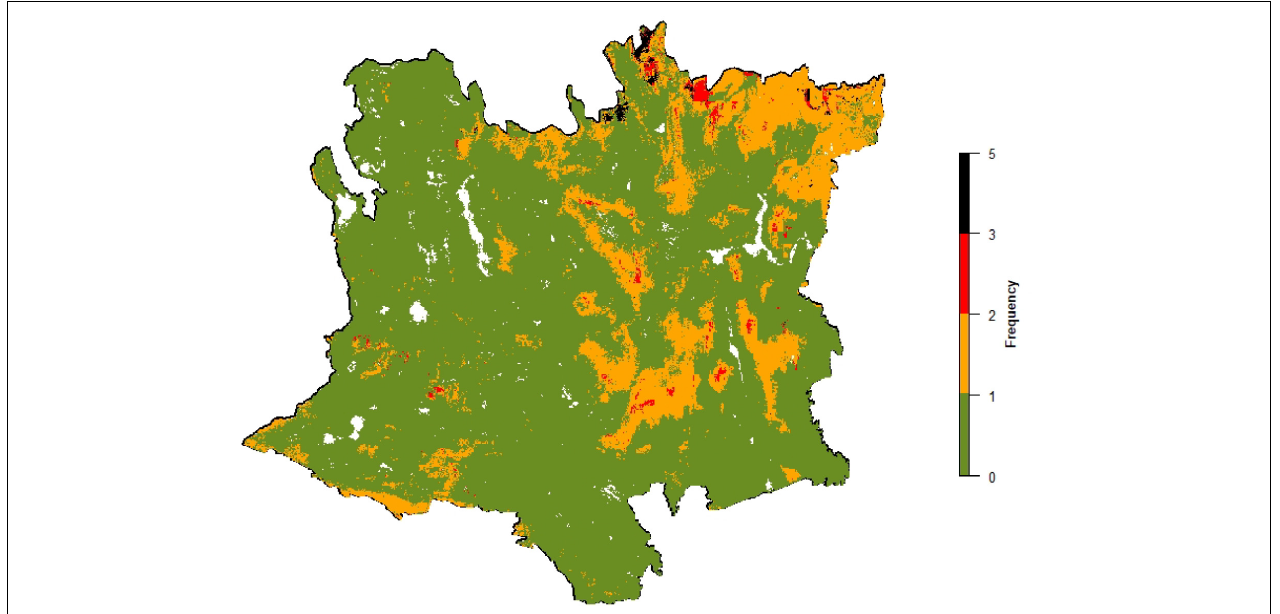
FIGURE 8 | Predicted distribution of fire frequency (Unburned, 1, 2, and > 2) resulting from large wildfires in the Mojave Desert of North America. Predictions were derived from a Random Forest model with 10 variables representing variability in topography, climate, vegetation, and lightning.